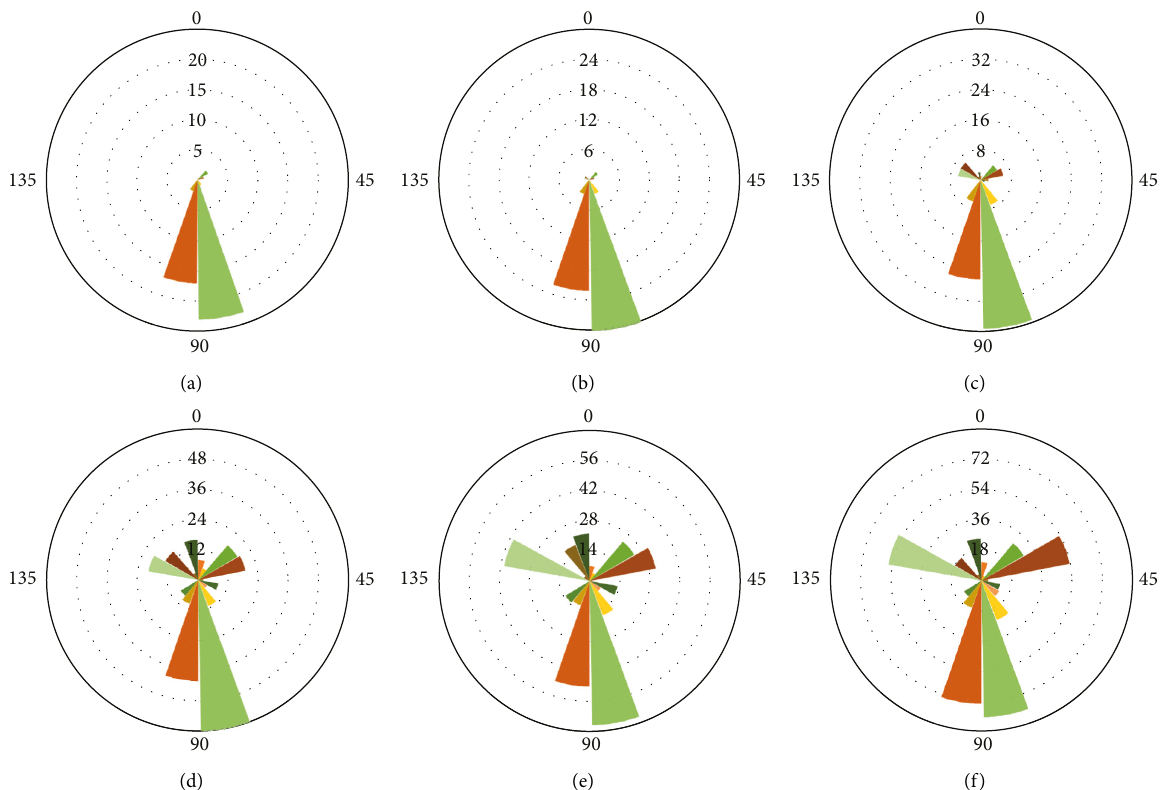
Figure 13: Distribution of crack orientation under different amplitudes: (a) 50%, (b) 60%, (c) 70%, (d) 80%, (e) 90%, (f) 100%.